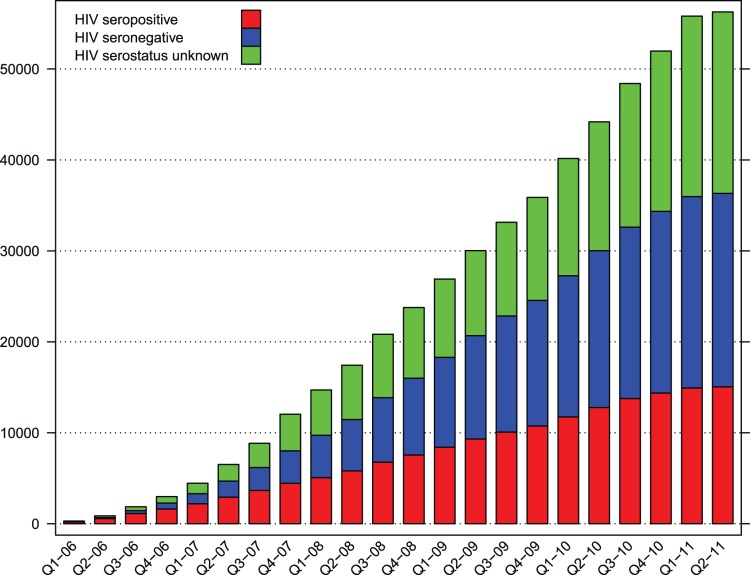
Cumulative enrollment of women in the Cervical Cancer Prevention Program in Zambia (CCPPZ) between January 2006–April 2011 by HIV serostatus.